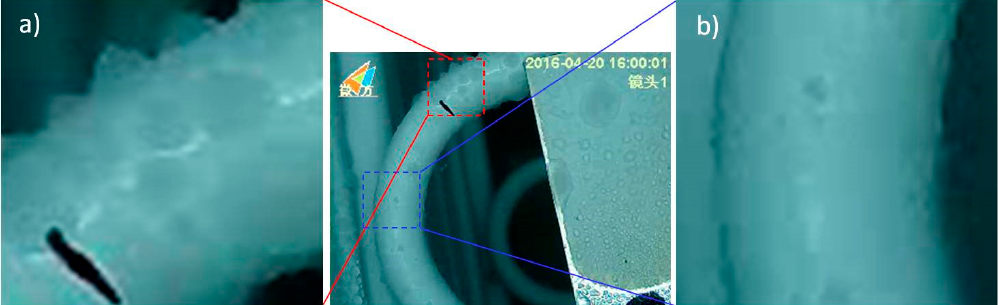
Figure 10. Frost formation process with different surface conditions: ( a ) normal surfaces; ( b ) PDMS-SiO 2 /PFA hybrid coating surfaces. Note: 微 方 is a brand and 镜 头 1 means camera